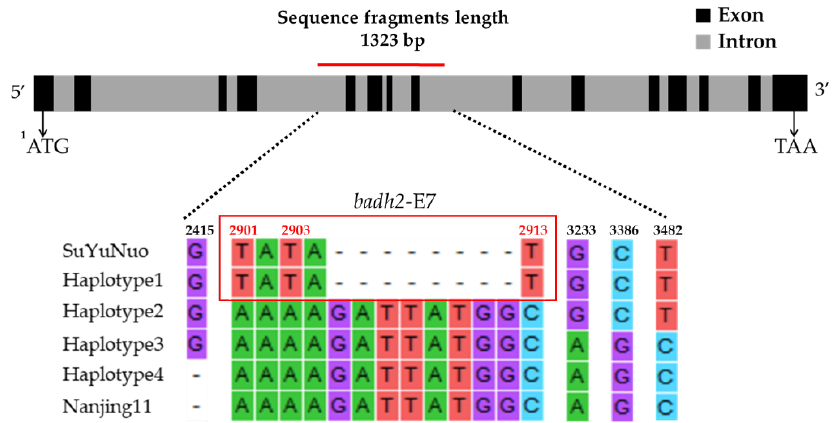
Figure 3. Extended haplotypes. Haplotype analysis of the sequence covering in the vicinity of badh2 -E7 regions. 2415 site was in intron 4; 3233, 3386 and 3482 sites were in intron 8 of the Badh2 gene.